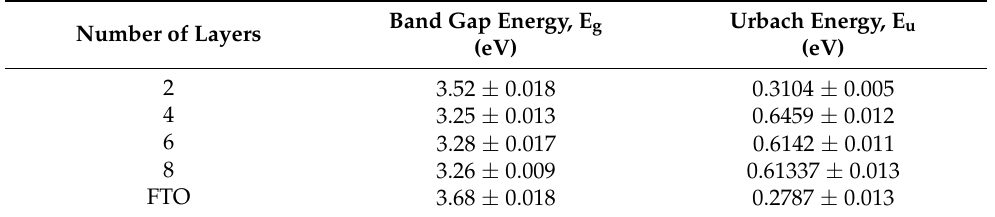
Table 2. Band gap and Urbach energies for TiO 2 thin films deposited on FTO substrate using sol–gel dip-coating at varying cycle